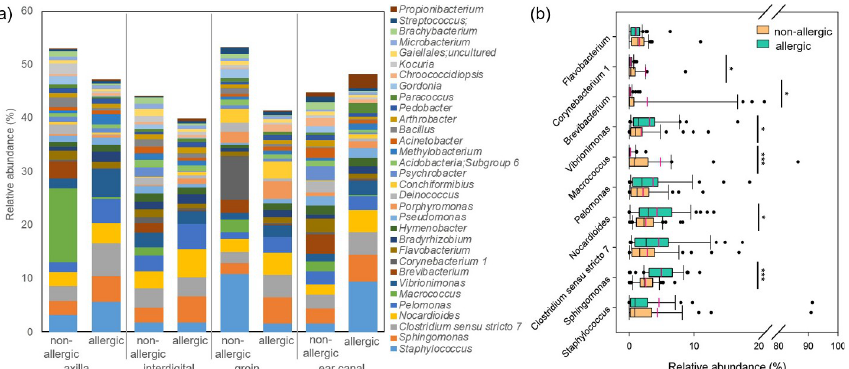
Fig 4. Phylogenetic composition of the skin (axilla, interdigital, groin) and ear canal microbiota of non-allergic (n = 12) versus allergic (n = 12) GSDs resolved at the genus level. (a) Mean relative abundances of bacterial genera identified in axilla, interdigital, groin and ear canal of non-allergic and allergic dogs. All genera with a total relative abundance of > 5% are depicted. (b) Relative abundance (across all body sites) of the 10 most abundant genera of non- allergic and allergic dogs. Asterisks are representing statistical significance: � p < 0.05; �� p < 0.01; ��� p <